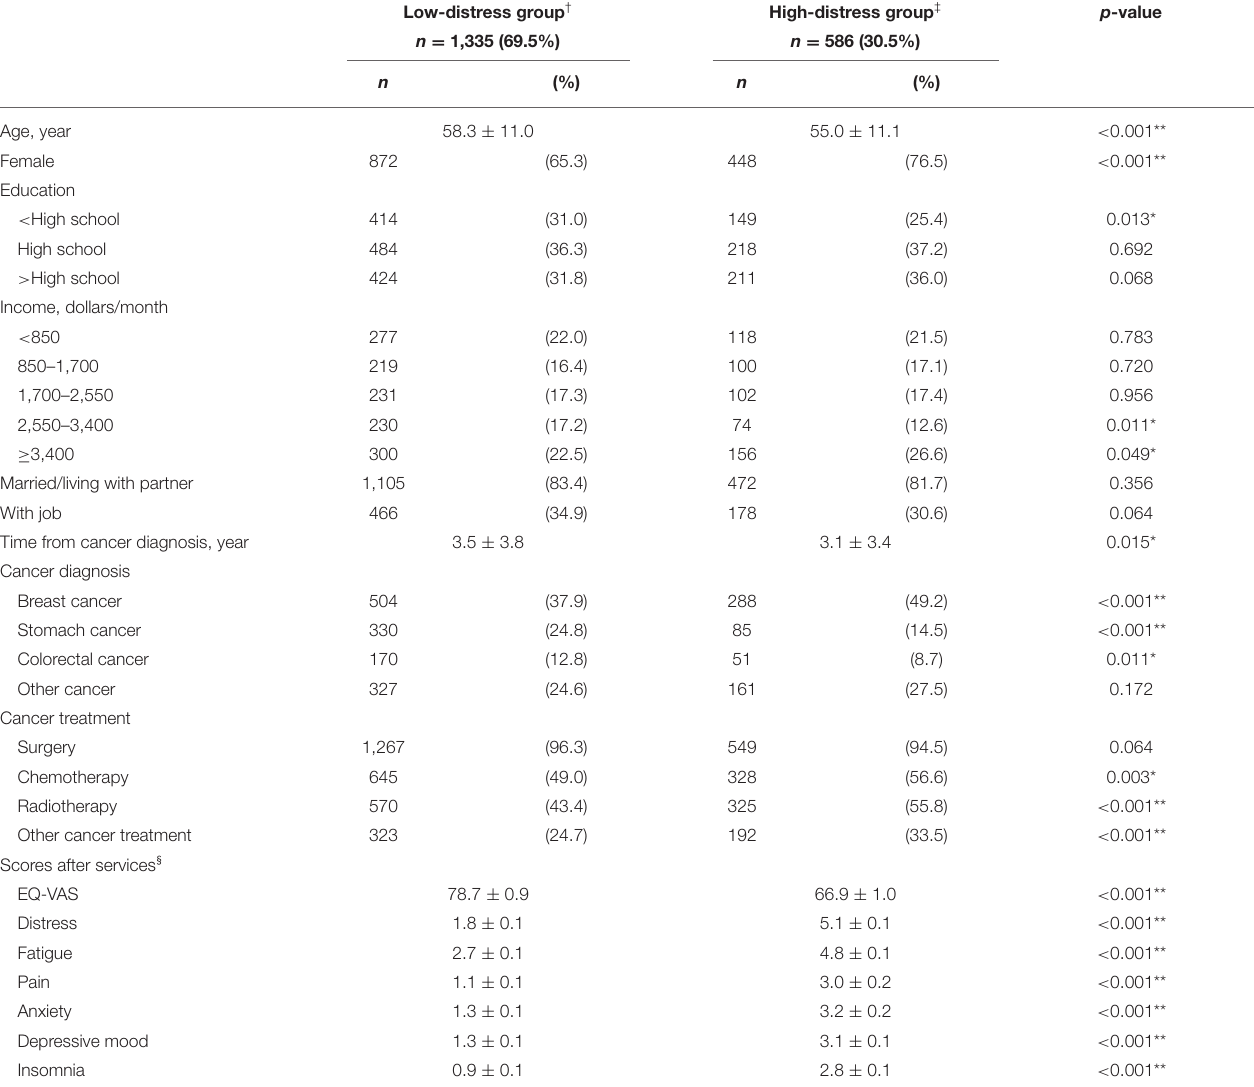
TABLE 2 | Characteristics of cancer survivors according to distress levels after using cancer survivor support